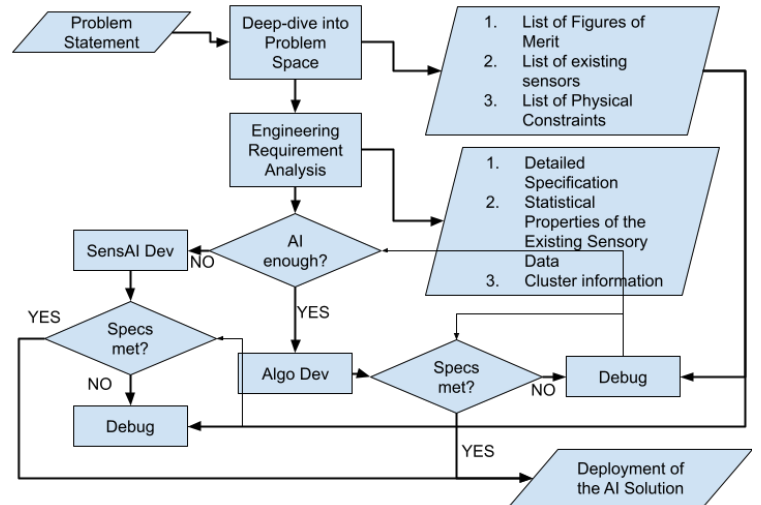
Figure 2. The suggested process to implement AI-based solutions for a mineral processing-related challenge. The modus operandi follows an agile approach and a spiral design flow. This is why there are multiple loops in the